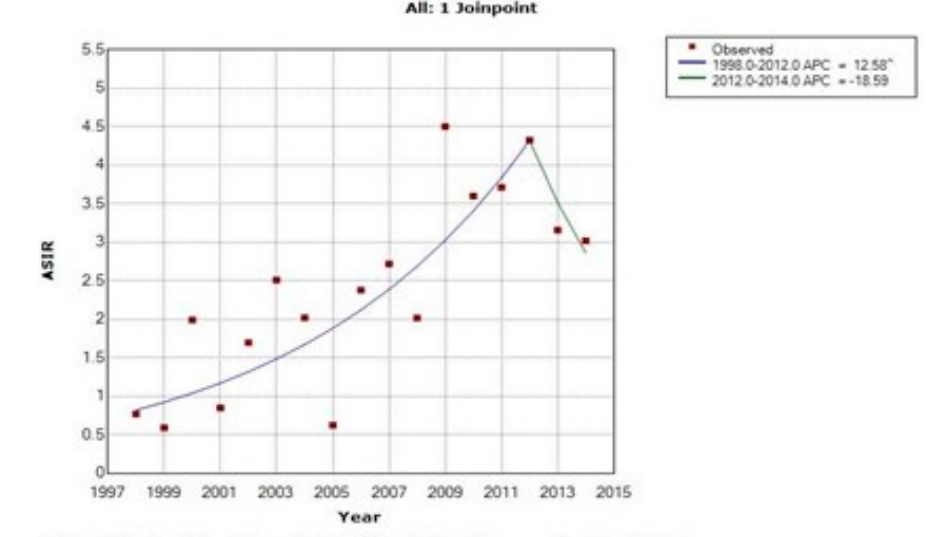
Figure 5. Time trends of age-standardized incidence rates of adenocarcinoma of cervix uteri, Cluj County, 1998–2014.